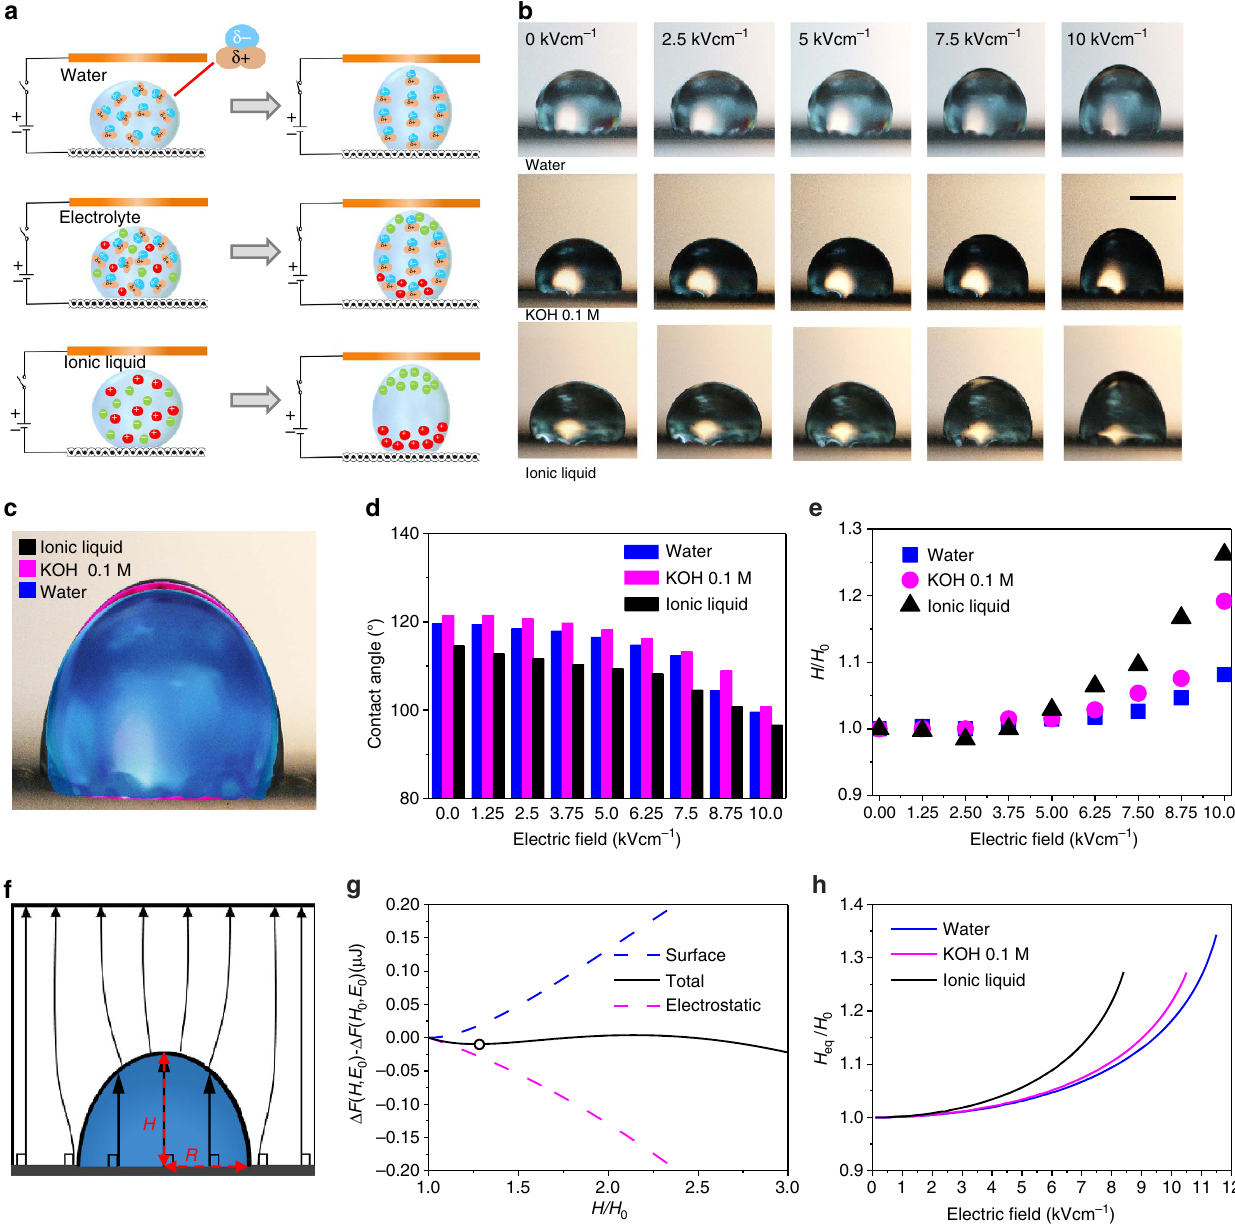
Figure 3 | Electrostatic actuation of liquid droplets under electric fields. ( a ) Shape control of three different liquids by electric field. ( b ) Optical images of liquid droplets (water, KOH 0.1M and ionic liquid) under different electric fields. Scale bark, 1mm. ( c ) Comparison of shape changes of three liquid droplets under electric field of 10kVcm (cid:3) 1 . ( d ) Changes of CA under different electric fields. ( e ) Variation of normalized height under electric fields. ( f ) Electric field flux when CA ¼ 90 (cid:2) . Under this condition, the electric field becomes uniform inside the droplet. ( g ) The free energy change as a function of droplet height under an applied electric field of E 0 ¼ 11kVcm (cid:3) 1 (solid line). Surface and electrostatic contributions are represented by dashed lines. The equilibrium droplet height is suitably predicted from the local minimum (marked by white circle). ( h ) The droplet height as a function of the applied electric field. Beyond the critical electric field, the droplet height prediction diverges, indicating the instability of the droplet. the calculation with a wide range of E 0 , we can predict the droplet electrowetting without concerning computationally expensive numerical solutions for general CAs. height as a function of the applied electric field, as depicted in Fig. 3h. The responses of the distilled water, the KOH solution and the ionic liquid differ owing to their different surface tensions and relative permittivity factors. The predictions of the conducting objects such as the droplets of KOH solution and ionic liquid, can be obtained at the limit of the infinite relative permittivity, that is, E i ¼ 1 (ref. 39). r The theoretical predictions are consistent with the Fig. 3g for the water droplet under E 0 ¼ 11kVcm (cid:3) 1 . By repeating experimental results in that the droplet height increases NATURE COMMUNICATIONS|7:13345|DOI: